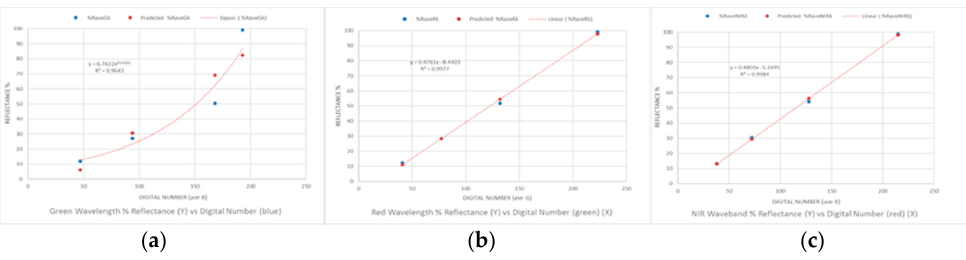
Figure 5. Plots of: Green ( a ); Red ( b ); and NIR ( c ) camera response functions for the Spectralon targets. The plots of spectral reflectance against sensor DN for the Dulux targets depict a strong positive linear relationship for all three wavebands as measured by Pearson’s correlation coefficient (0.986 red < R Dulux > 0.989 green ). For all sensor wavebands the coefficient of determination exceeds 0.971. The plots of spectral reflectance against sensor DN for the Spectralon calibration target depict a strong linear correlation for Red and NIR wavebands (R = 0.999) and an exponential relationship for the Green waveband. R 2 for Red and NIR were both 0.998 and lowest at 0.964 for Green.